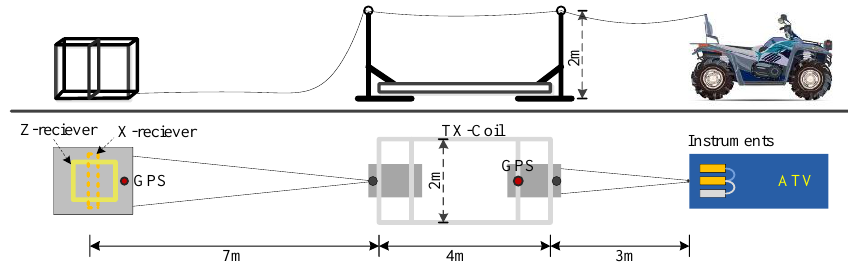
Figure 1. The schematic of the tTEM system.